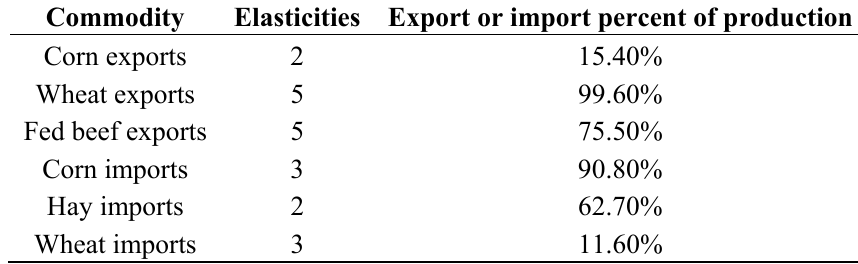
Table 6. Export and import elasticities in the Colorado EDMP, and trade proportions for key